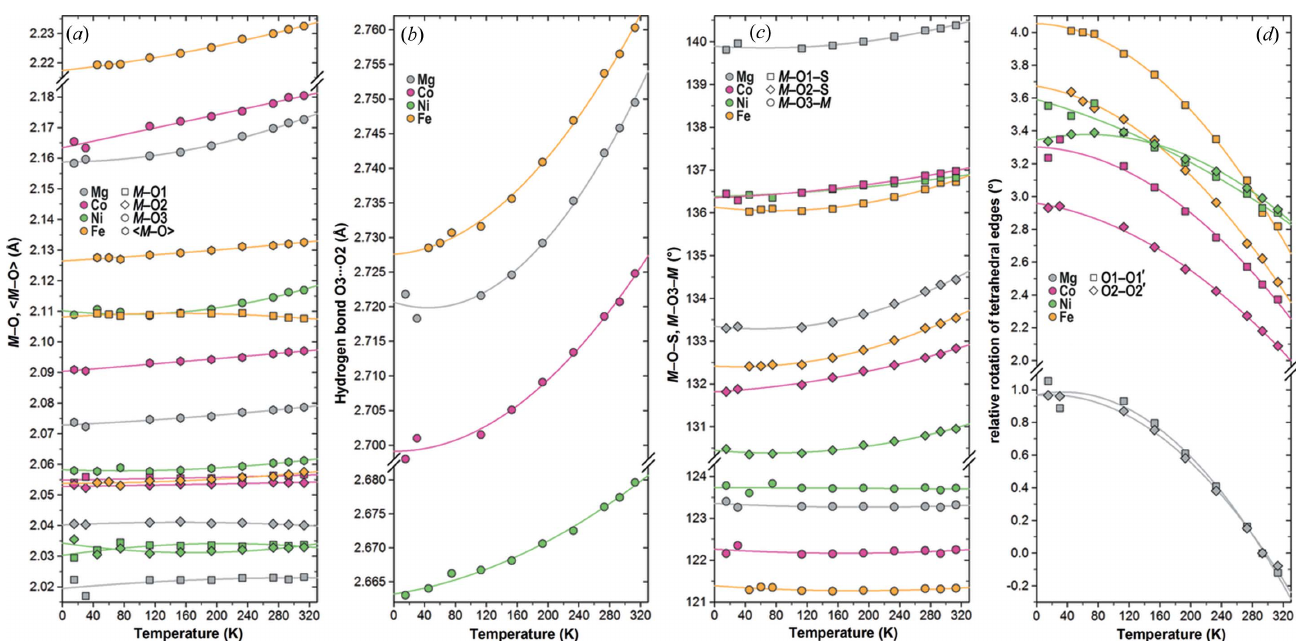
Figure 4 Selected stereochemical parameters of kieserite-type compounds M 2+ SO 4 (cid:2) H 2 O ( M 2+ = Mg, Fe, Co, Ni) in the temperature range 15–313 K with second- order regression lines. ( a ) Individual and mean M —O bond lengths, ( b ) O3—H (cid:2)(cid:2)(cid:2) O2 hydrogen bond lengths, ( c ) M —O—S and M –O3– M angles at polyhedra-linking oxygen atoms, and ( d ) rotations of tetrahedral O1—O1 0 and O2—O2 0 edges relative to those in the Mg compound at 293 K. For errors see the underlying structural data in Tables S1, S2 and